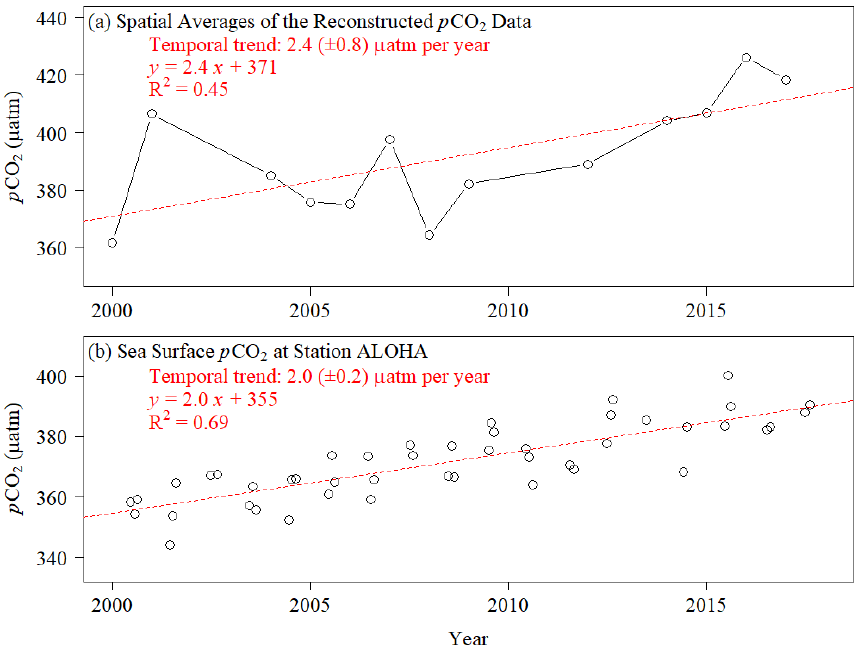
Figure 11. (a) Time series and linear trend of the spatial averages of the reconstructed summer p CO 2 data in the SCS in the period of 2000–2017; (b) summer sea surface p CO 2 at Station ALOHA in the years 2000–2017 adapted from Dore et al. (2009).